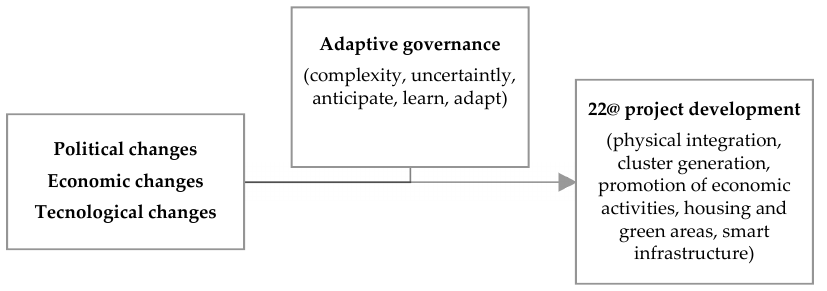
Figure 1. Theoretical framework .